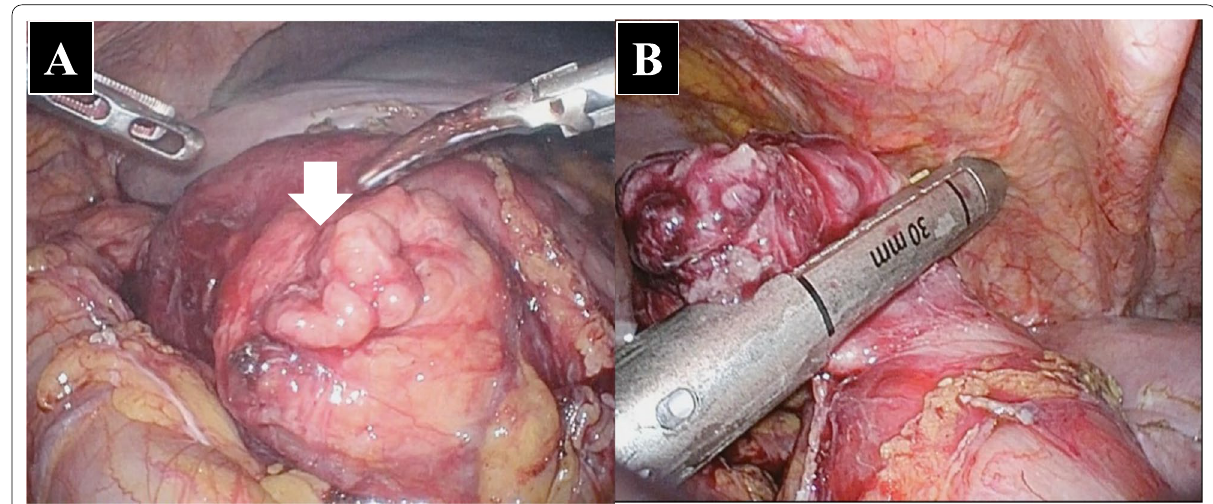
Fig. 2 Intraoperative findings. A Intraoperative findings: the perforated anterior duodenal wall ( white arrow ) was detected, and intestinal fluid was observed to be flowing out. B The perforated site was resected using an autosuture